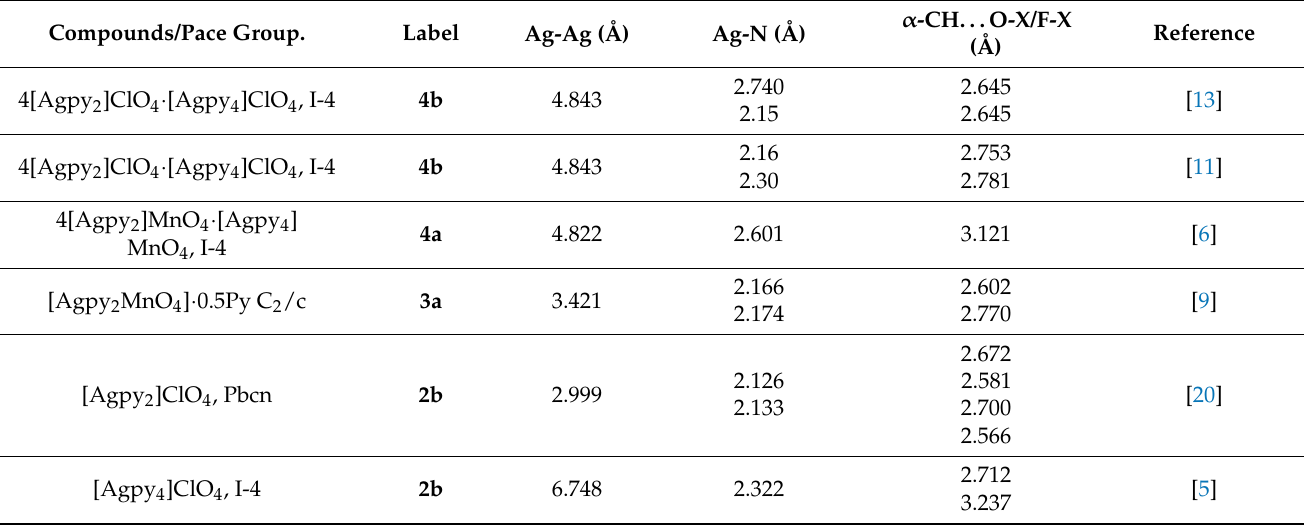
Table 3. The main crystallographic parameters of [Ag(py) 2 ]MnO 4 , [Ag(py) 2 ]ClO 4 , [Ag(py) 2 ]ReO 4 , and [Ag(py) 2.4 ]MnO 4 . Compounds/Pace